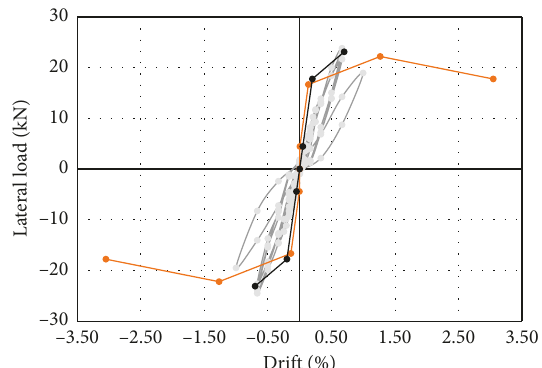
Figure 14: Comparison between experimental data and theoretical models for specimen